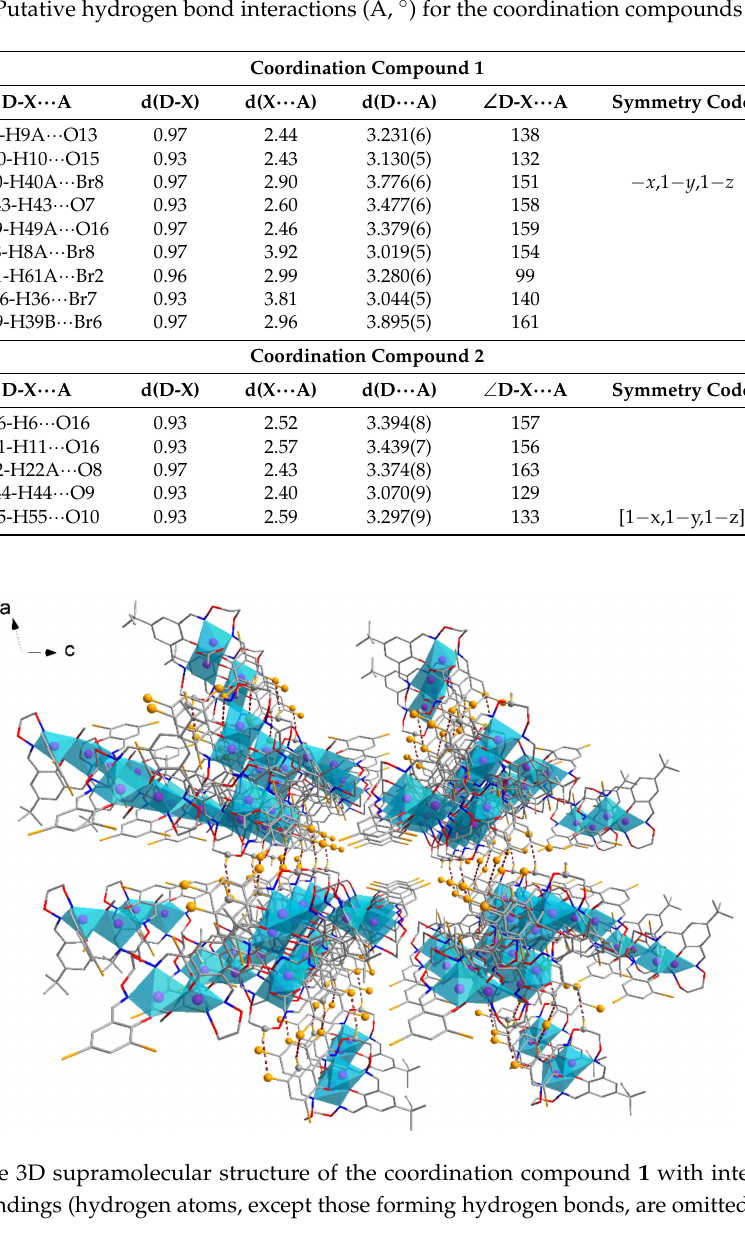
Table 2. Putative hydrogen bond interactions (Å, ◦ ) for the coordination compounds 1 and 2 .